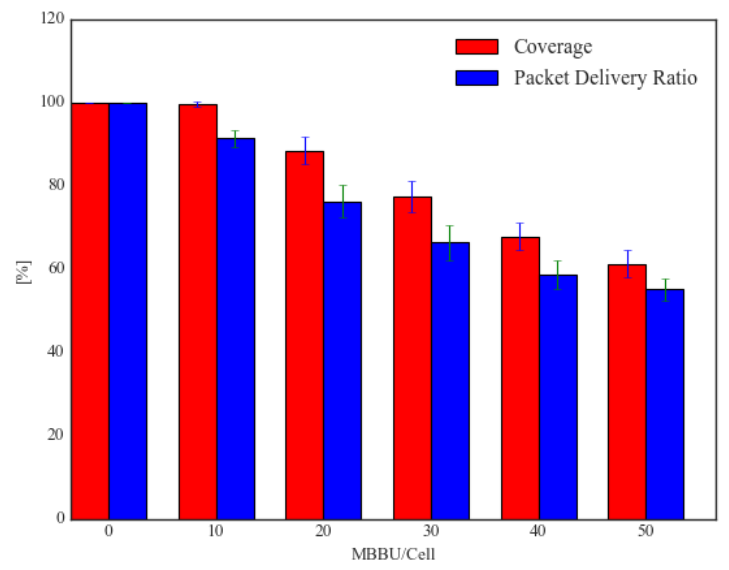
Figure 11. Coverage and packet delivery ratio in background traffic scenario.